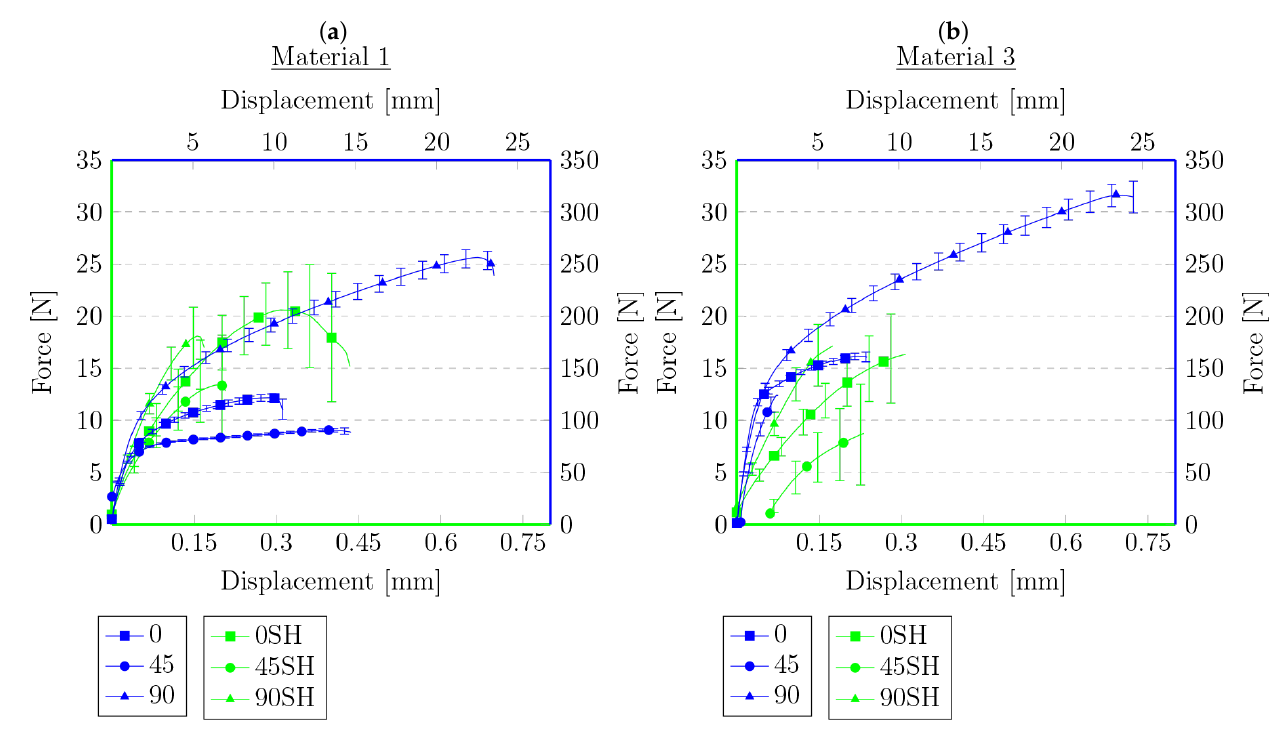
Figure 8. Force–displacement graphs for primary samples (blue) and samples cut with a knife and heated (green) for materials for which connection was established with respect to the angle of reinforcement relative to the sample’s longitudinal axis: ( a ) 0°, ( b )